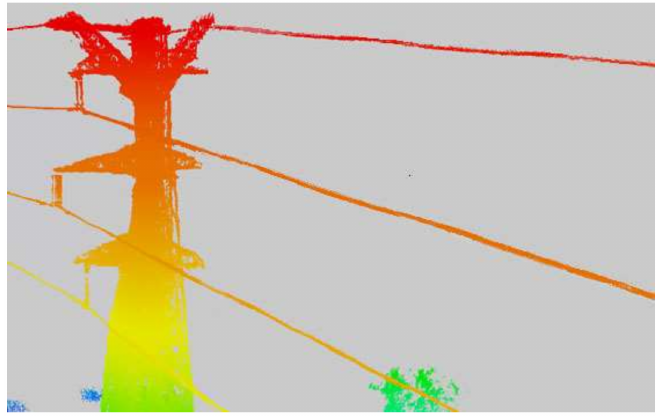
Figure 10. Point cloud of the third